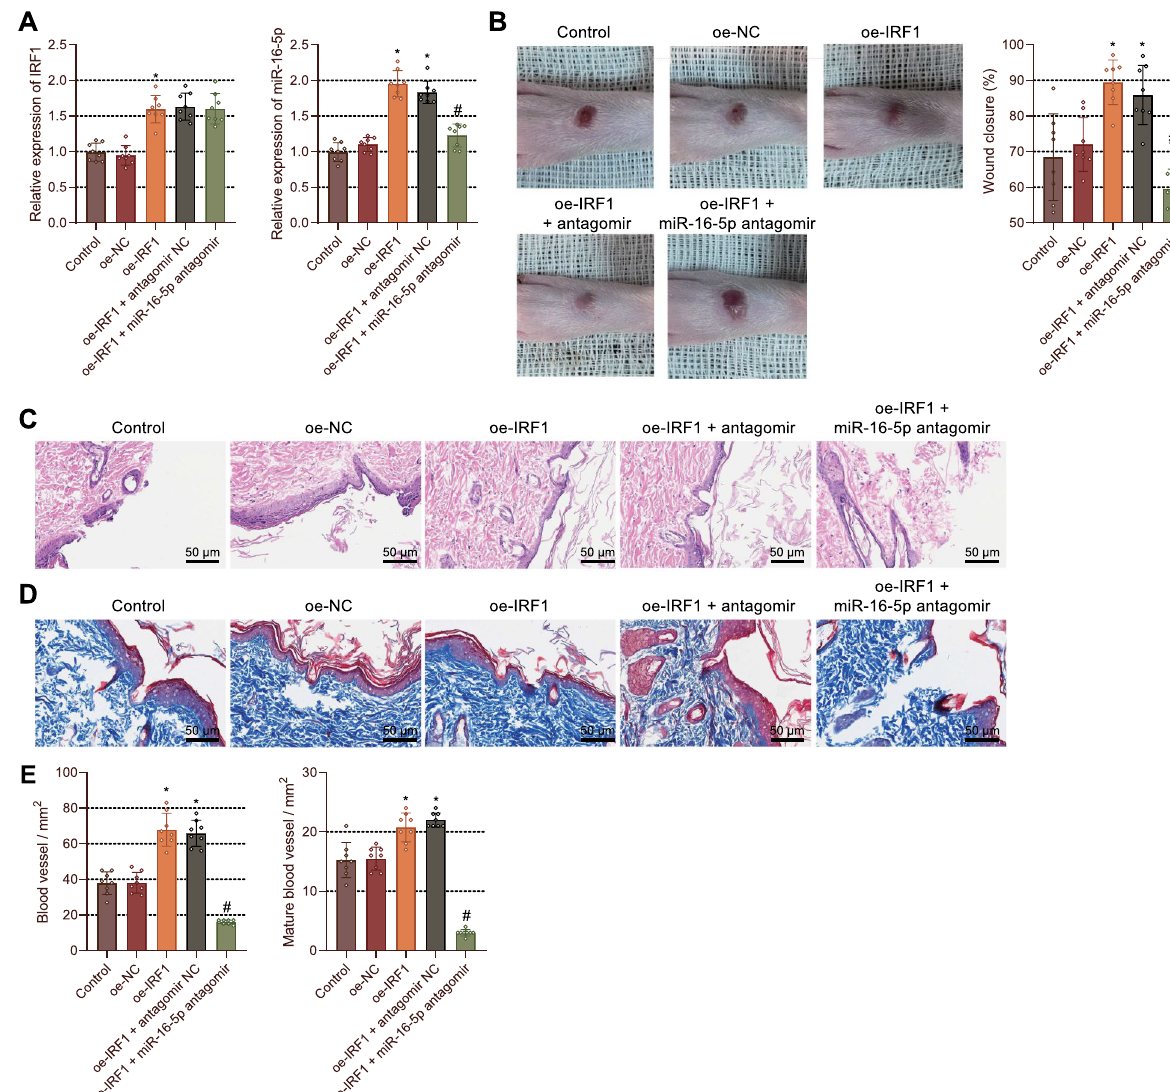
Fig. 4 IRF1 enhances the wound healing in DM rats by upregulating the expression of miR-16-5p. DM rats were treated with oe-IRF1, oe-IRF1 antagomir NC, or oe-IRF1 miR-16-5p antagomir. A The expression of IRF1 and miR-16-5p in the rat wound tissues determined by + + RT-qPCR on day 14. * p < 0.05 vs. oe-NC-treated rats. # p < 0.05 vs. oe-IRF1 antagomir NC-treated rats. B , Changes in foot wound diameter in + rats on day 14. * p < 0.05 vs. oe-NC-treated rats. # p < 0.05 vs. oe-IRF1 antagomir NC-treated rats. C Morphological and structural changes of rat + wound tissues observed by HE staining. D Collagen deposition in the rat wound tissues analyzed by Masson staining on day 14. * p < 0.05 vs. oe-NC-treated rats. # p < 0.05 vs. oe-IRF1 antagomir NC-treated rats. E Quantitative analysis of newly formed (left) and mature (right) blood vessels + in rat wound tissues on day 14 assessed by immunohistochemical and immunofluorescent staining. * p < 0.05 vs. oe-NC-treated rats. # p < 0.05 vs. oe-IRF1 antagomir NC-treated rats. n 8. Measurement data were presented as mean standard deviation. Data among multiple groups were + = ± compared by one-way ANOVA, followed by Tukey’s post hoc test for multiple comparisons. Repeated measures ANOVA with Tukey’s post hoc